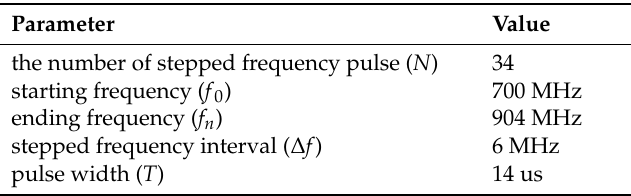
Figure 22. The structure of the experiment platform. In this figure, DDS is Direct Digital Synthesizer Unit, PLL is Phase Locked Loop Unit, A/D is Analog-to-Digital Converter and ARM is Advanced Reduced Instruction Set Computer Machines. Table 4. Platform’s parameter